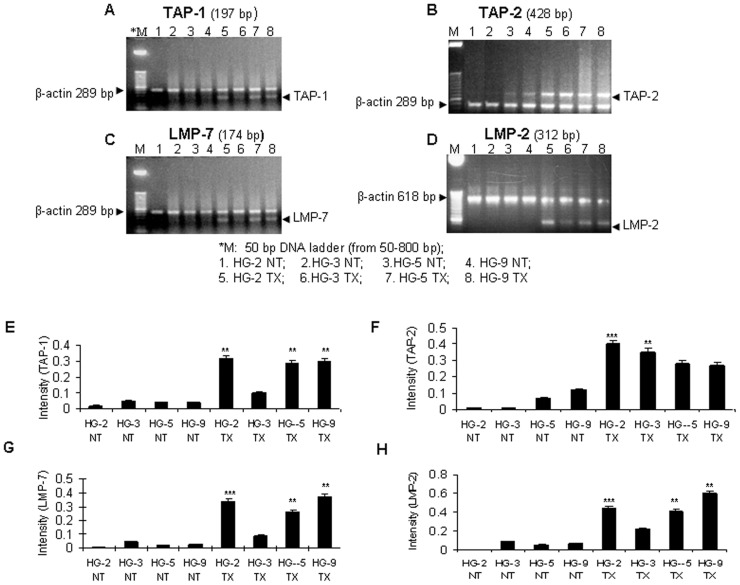
Comparison in expression of TAP and LMP transcripts in pAnti IGF-1 transfected (TX) and non-transfected (NT) HGB cell lines.RNA was prepared from cell lines established from four different patients. Following incubation of cells in the presence of 50 µM ZnSO4 for 18–20 hrs, agarose gel eletrophoresis and ethidium bromide staining were used to characterize products of RT-PCR for A, TAP-1; B, TAP-2; C, LMP-7; and D, LMP-2. Primer pairs for β-actin were included in each experiment as internal control. Expected sizes of RT-PCR products were: TAP-1, 197 bp; TAP-2, 428 bp; LMP-7, 174 bp; LMP-2, 312 bp; β-actin, 289 bp except in experiments concerning expression of LMP-2 in which the primer pair for the 618 bp fragment was used. Molecular weight markers are multiples of 50 bp from 50 to 800. Please note that Fig 4 A – D represent the results for one set of three similar RT-PCR experiments; E – H represent the results for the three sets of data analyzed together using the Epson Scan program for densitometry. Each TX cell line was compared to the respective NT cell line. Significance ** p<0.05, *** p<0.001.